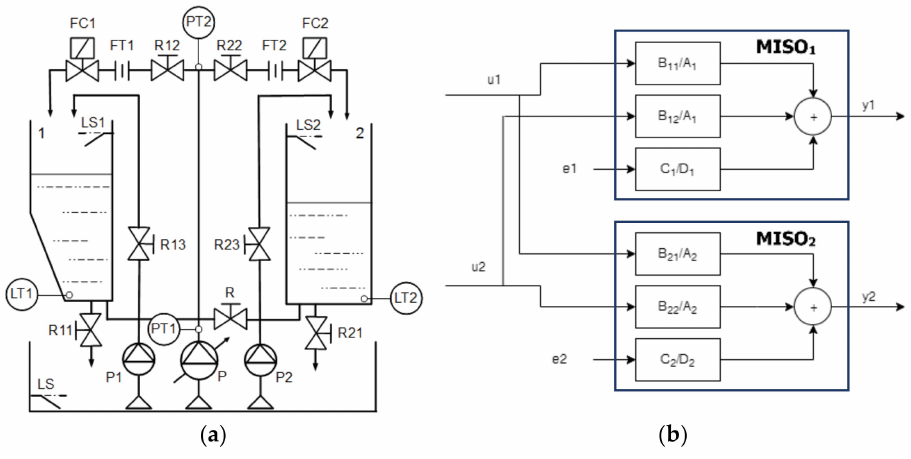
Figure 1. ( a ) ASTANK2 block-diagram. ( b ) ASTANK2 global identification